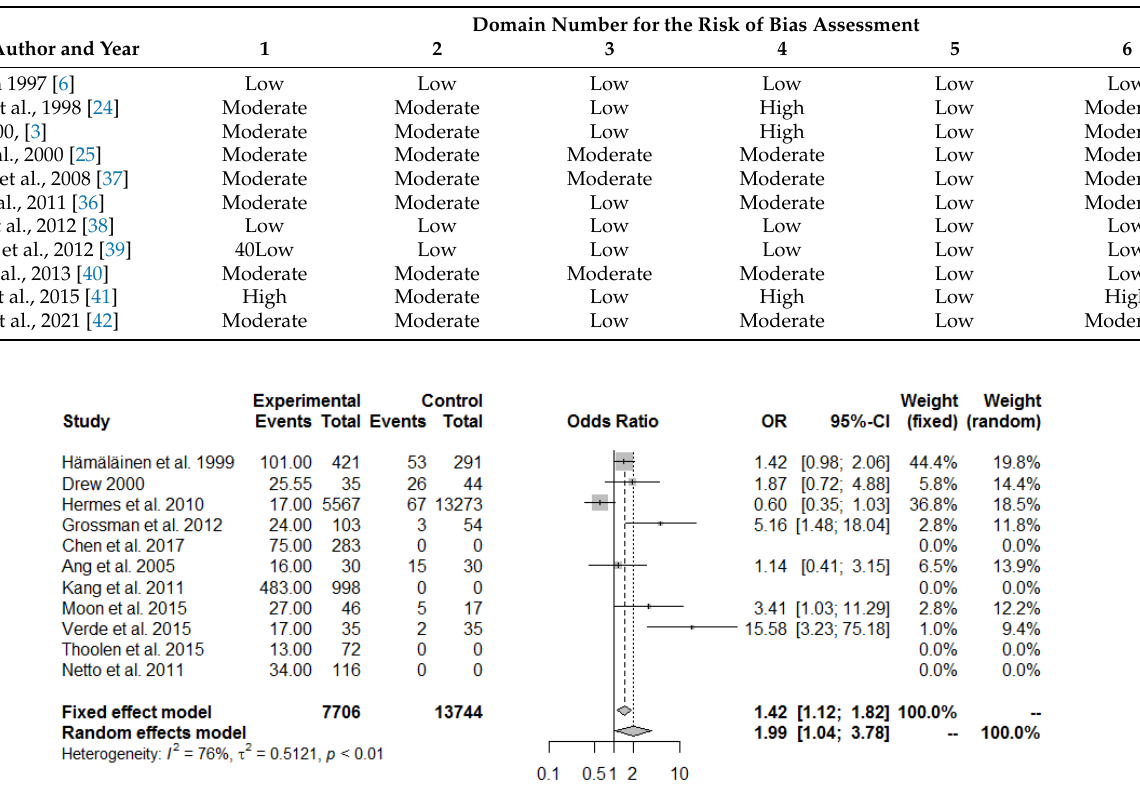
Table 2. Risk of bias assessment for the six domains for each study for the second research question.